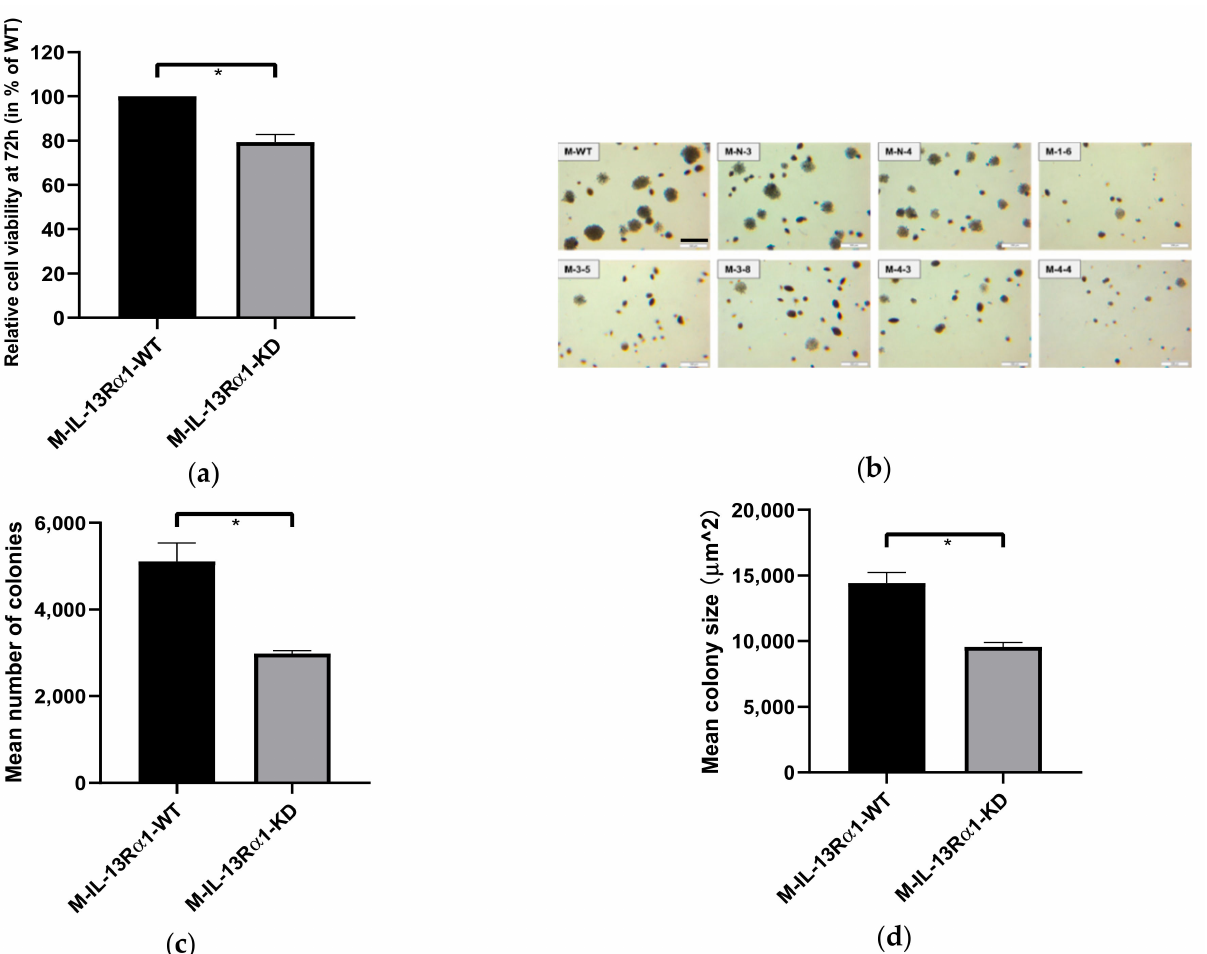
Figure 3. Effect of IL-13R α 1-downregulation the basal growth of M-WT, M-N and M-KD clones. ( a ) Basal anchorage-dependent growth of MIAPaCa-2 control groups and IL-13R α 1-downregulated clones in the MTT assay. Relative cell growth at 72 h is shown as mean cell viability in % ( ± SEM) compared to M-IL13-R α 1-WT and are means of 5 independent experiments of sextuplicate determi- nations; ( b ) Colonies formed in soft agar. Representative pictures show colonies formed by M-WT, M-N-3, M-N-4, M-1-6, M-3-5, M-3-8, M-4-3 and M-4-4 cells growing in soft agar after 21 days at 4x magnification. Pictures of colonies in 6-well plates were taken at random position in each of 9 fields per well. Scale bar: 500 µ m. M-WT and M-N cells formed more and larger sizes of colonies; ( c ) Mean number of colonies ( ± SEM) and ( d ) mean colony size in µ m 2 ( ± SEM) in one well (9.4 cm 2 ) of 6-well plate. Data shown were performed as means of 3 independent experiments. (ns p > 0.05, * p < 0.05). These findings were replicable in MIA PaCa-2 (Figures 3 and S6d–f). Thus, IL-13R α 1-downregulation reduced pancreatic cancer cell survival in both anchorage-dependent and -independent assays. Ab- breviations: M-IL-13-R α 1-WT: Biological replicates with normal IL-13R α 1 expression (WT and sham transfected Neo clones), M-IL-13-R α 1-KD: Biological replicates with reduced IL-13R α 1